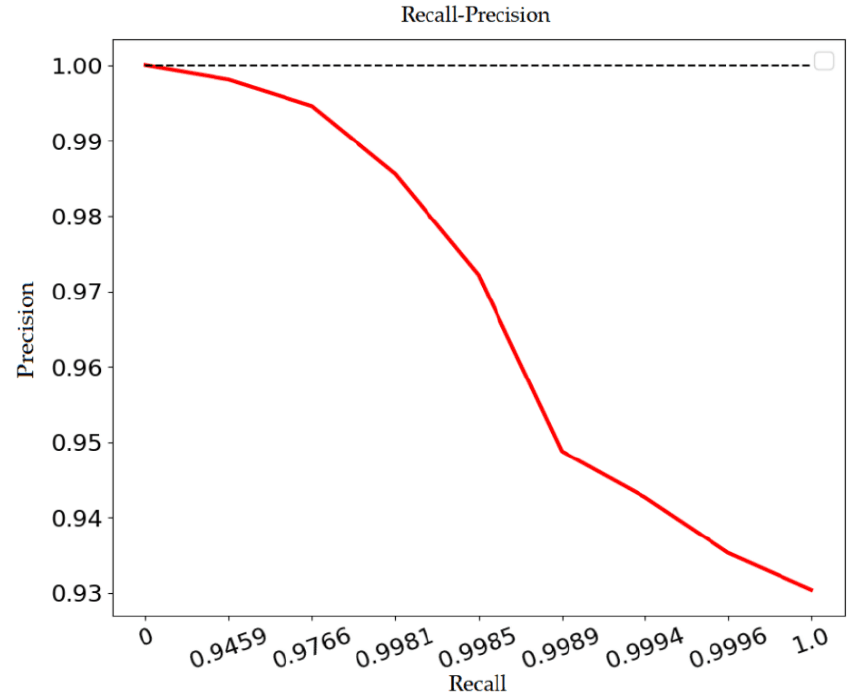
Figure 2. Relationship between recall rate and precision